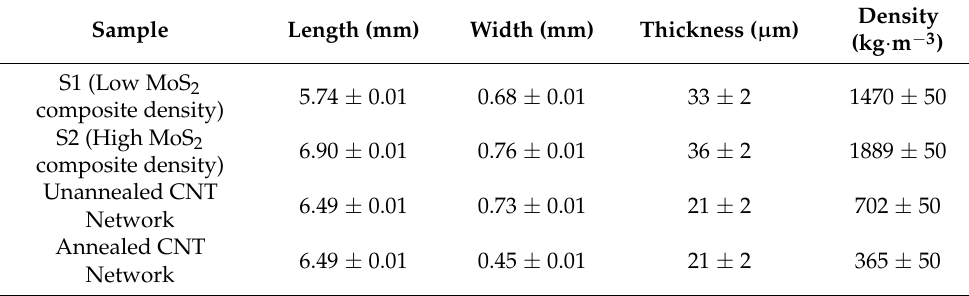
Table 2. Details of the samples measured in this